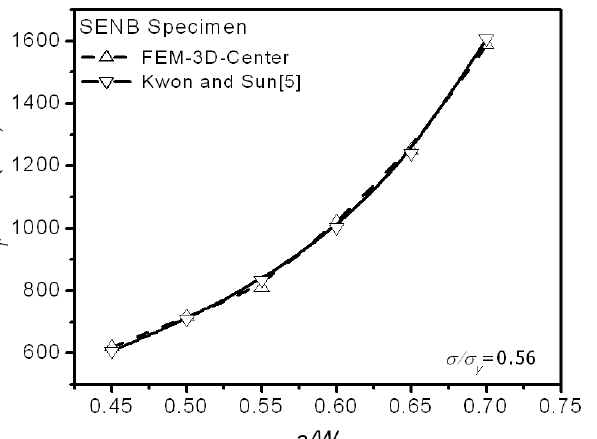
for various a/W ratios obtained by I